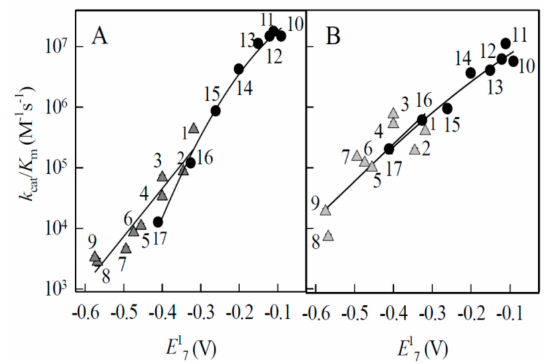
Figure 2. Dependences of bimolecular rate constants of enzymatic single-electron reduction of ArN → O and quinones on their single-electron reduction midpoint potential. ( A ) The reactivity of ArN → 0 (triangles) and quinones (circles) in P-450R-catalyzed reactions. ( B ) The reactivity of ArN → 0 (triangles) and quinones (circles) in ADR / ADX-catalyzed reactions. The numbers of compounds correspond to those in Table 1. The reactivity of ArN → 0 and quinones are described by the first order and second order polynomial regressions,